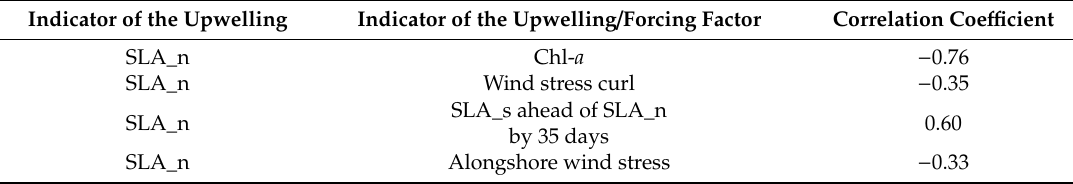
Figure 9. Time series of climatologically weekly Chl- a concentrations, wind stress curl, alongshore wind stress, SLA_n and SLA_s ahead of SLA_n by 35 d from January to April (all data are averaged during 2003–2016 and normalized by one standard deviation). Table 1. The correlation coefficients between indicator of the upwelling (SLA_n and Chl- a ) and forcing factors.